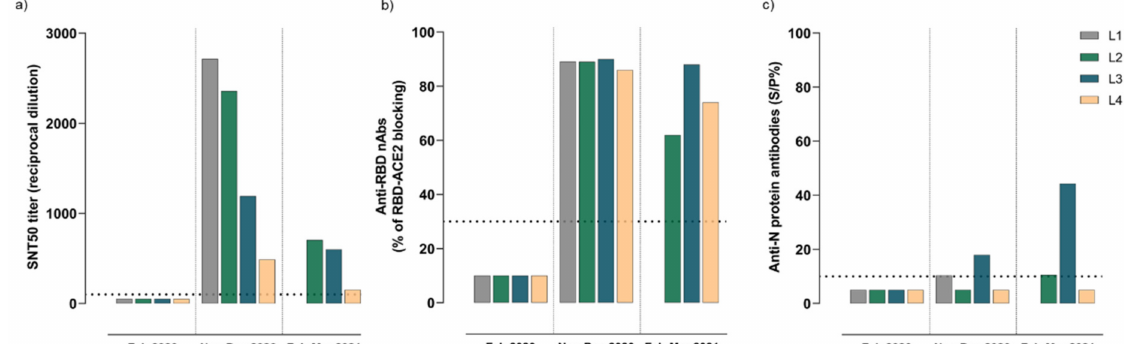
Figure 4. Antibody responses to SARS-CoV-2 elicited in sera from naturally infected lions (L1-L4). ( a ) SARS-CoV-2 neutralizing antibodies determined by the seroneutralization assay. ( b ) Virus-neutralizing antibodies targeting the RBD of the SARS-CoV-2, as determined by the surrogate virus neutralization assay. ( c ) Reactive antibodies against the nucleocapsid (N) protein of the SARS-CoV-2 measured by an in-house ELISA. Each colored bar represents an individual animal. The horizontal dotted lines indicate the cutoff of each assay. Abbreviations: SNT50, serum virus neutralization titer conferring the reciprocal value of the sample dilution that showed 50% protection of virus growth; RBD, receptor-binding domain; nAbs, virus neutralizing antibodies; ACE2, angiotensin-converting enzyme 2; L1, Lion1; L2, Lion2; L3, Lion3; L4, Lion4; N, nucleocapsid protein; and S/P%, percentage of reactivity compared with the positive control included in each